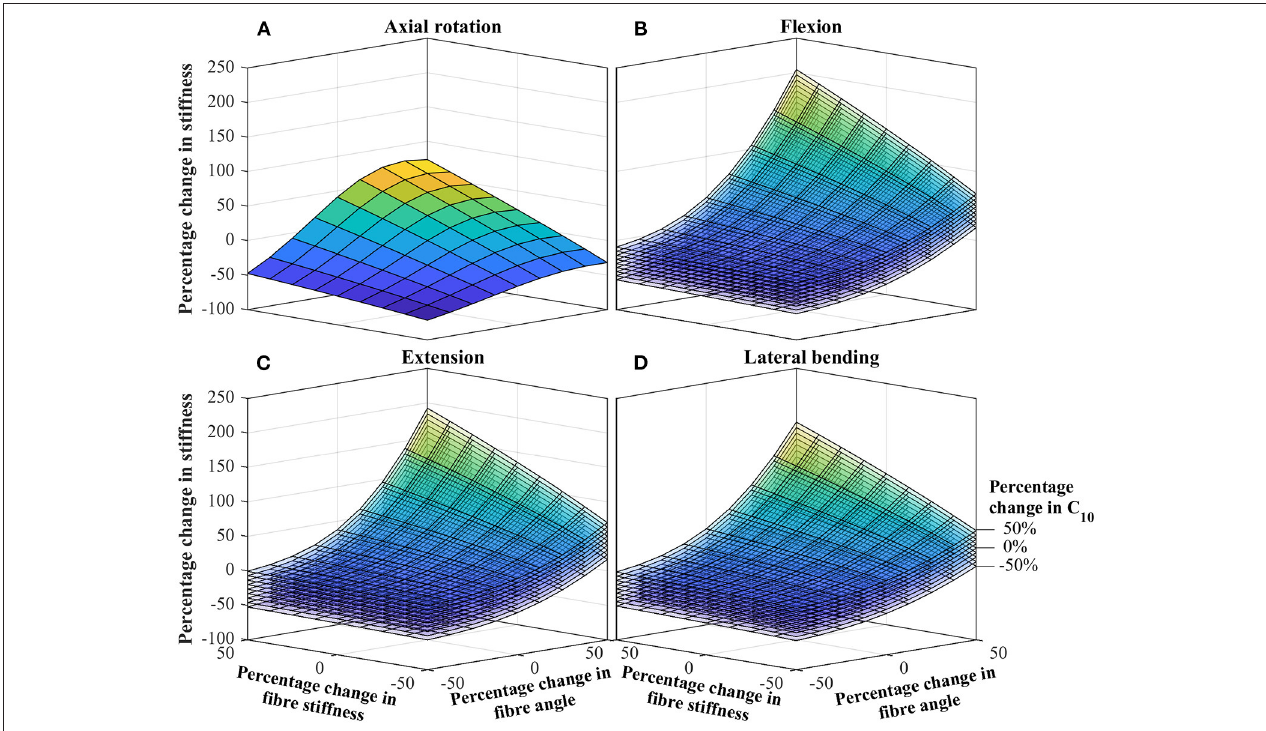
FIGURE 4 | Percentage change in IVD stiffness as a function of combined changing of significant parameters. (A) Axial rotation. (B) Flexion. (C) Extension. (D) Lateral bending. The stack of curves in (B–D) are for the percentage change in C 10 as identified in (D) . Contour plots of the same data is presented in the Supplementary Material